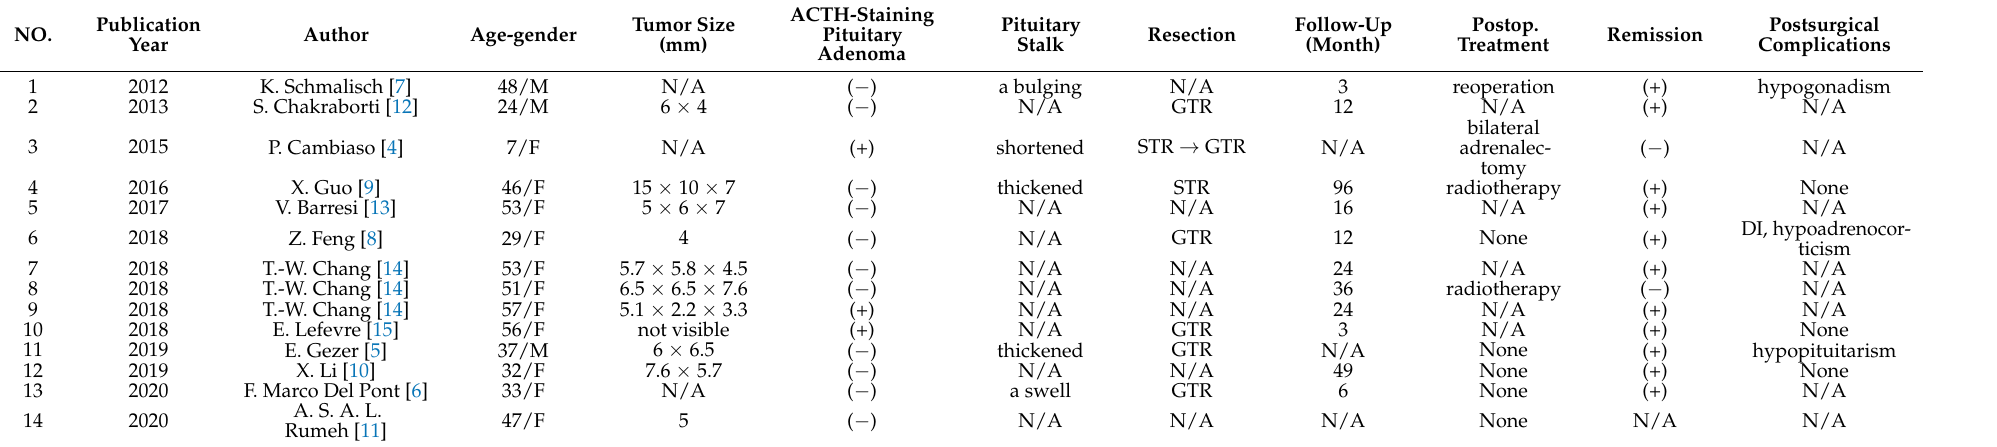
Table 3. Summary of patients with suspected Cushing’s disease associated with